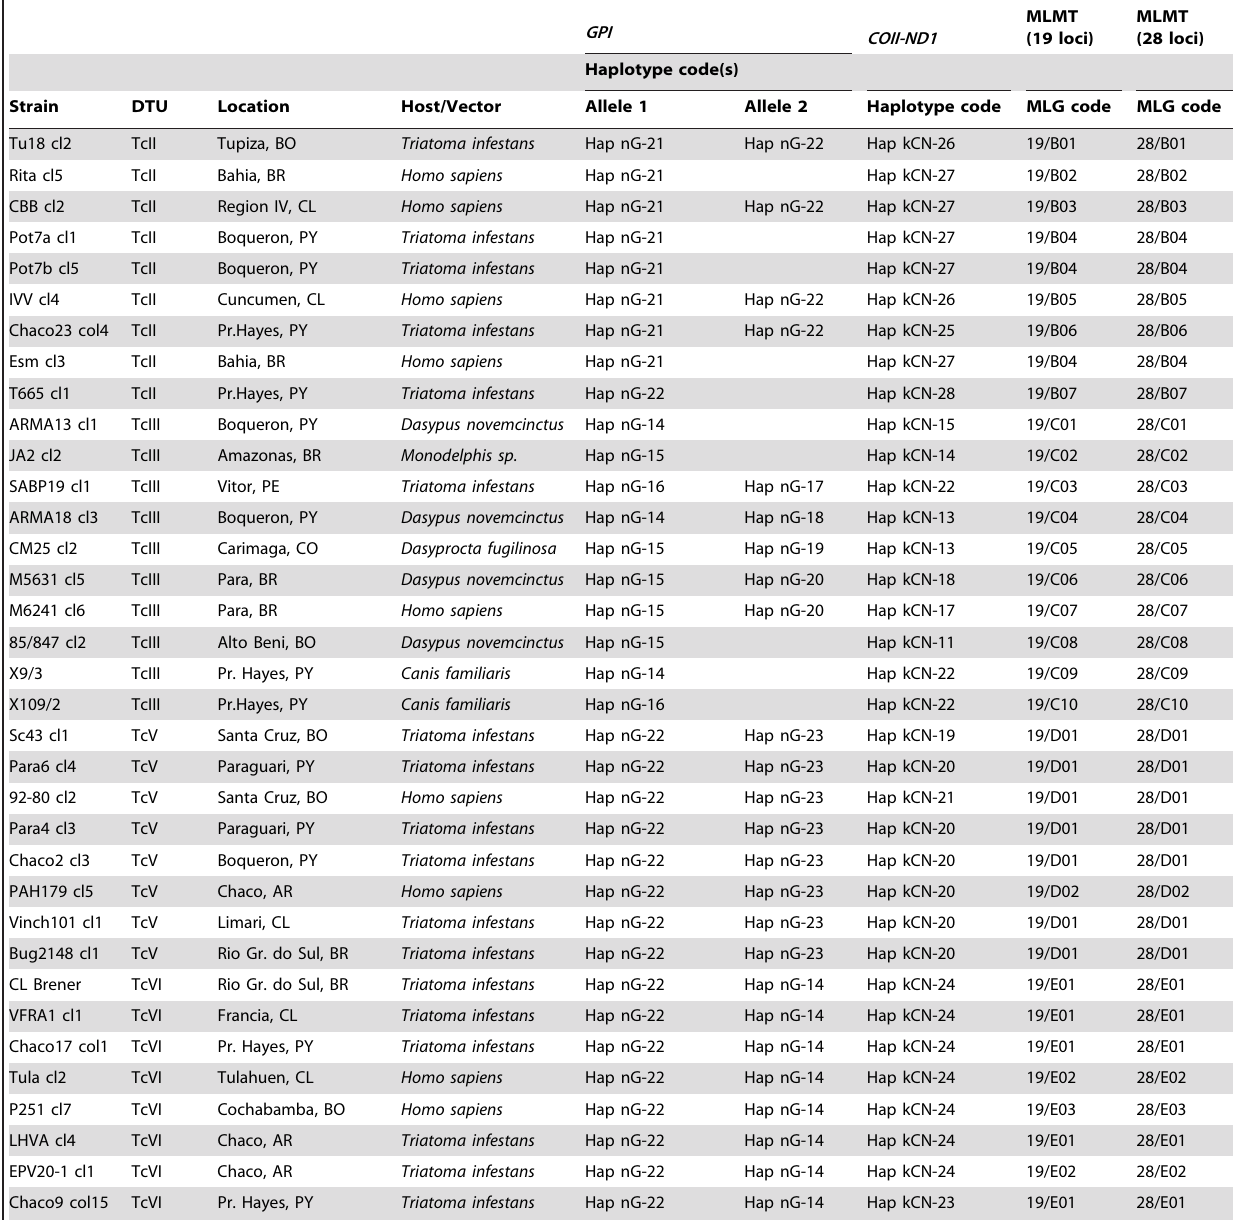
Table 1. Genotypes for core samples analysed in the